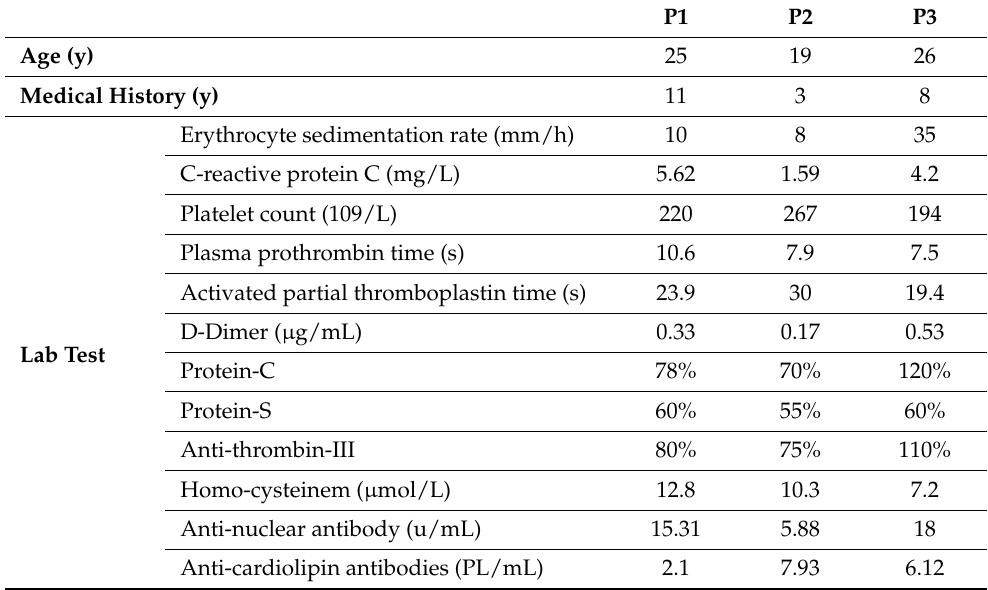
Table 1. The lab test results of the three